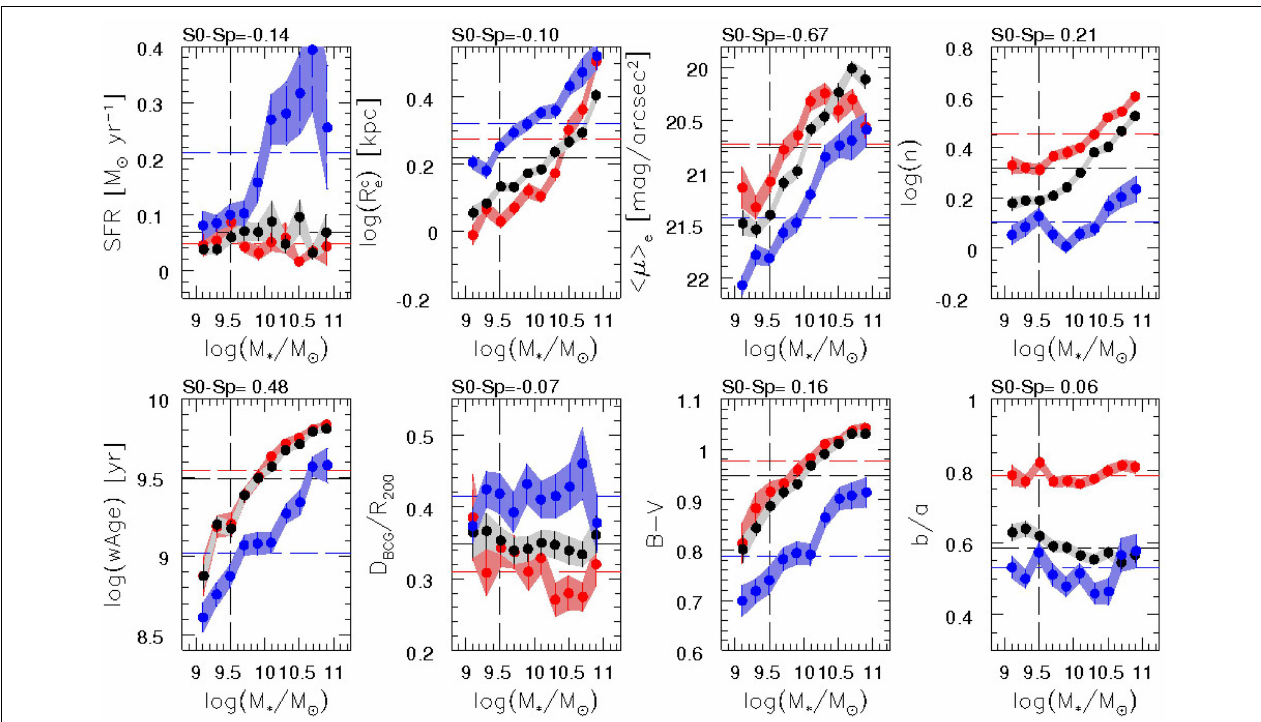
FIGURE 7 | From top left to bottom right we plot here vs. the log mass of the galaxies in solar units the following average quantities derived for the different morphological types in various bins of D BCG / R 200 : the star formation rate (SFR), the log of the circularized effective radius (log( R c e [ kpc ]), the mean effective surface brightness in R 200 units ( h µ i e ), the log Sersic index (log ( n )) , the log of the luminosity weighted age (log ( wAge ) ), the